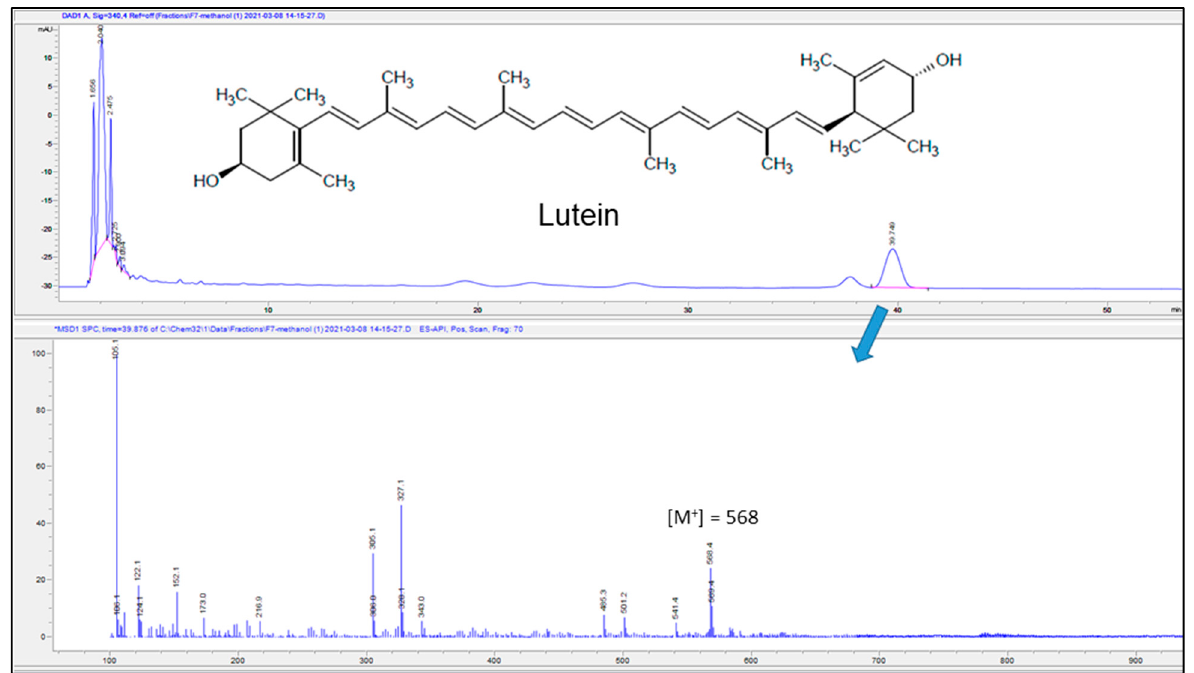
Figure 3. LC–MS chromatogram of lutein ( top ) along with its obtained ESI spectrum ( bottom ).